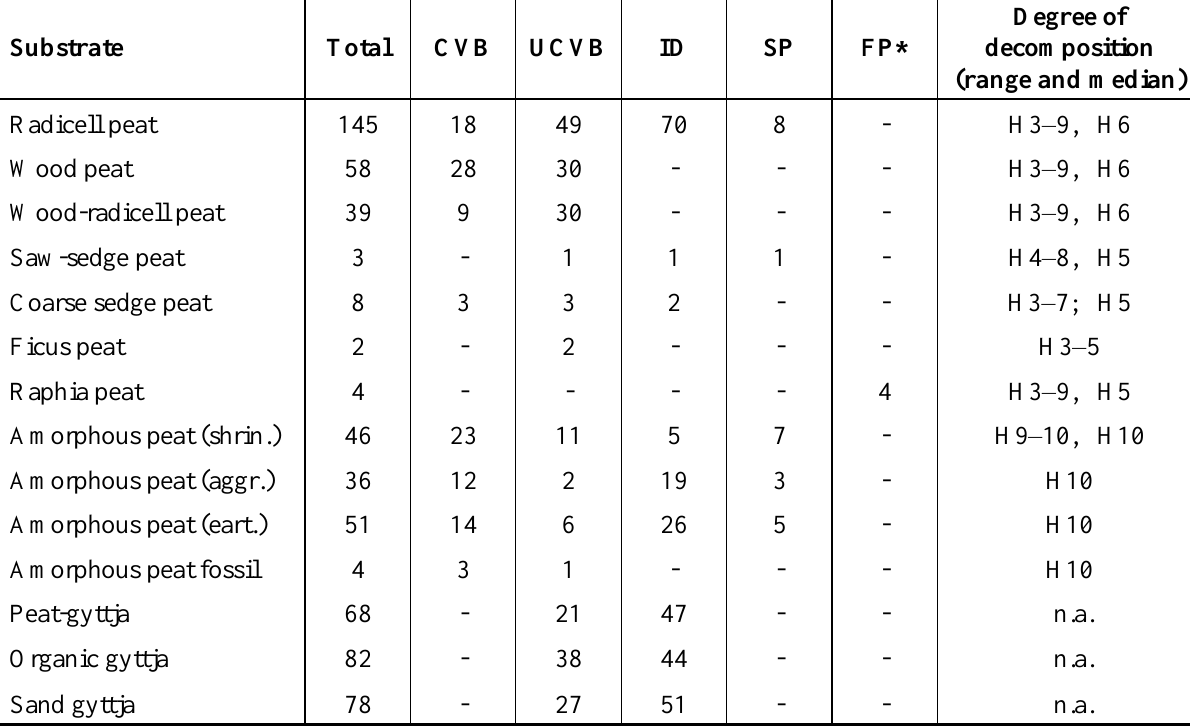
Table 4. Frequencies of horizons belonging to individual substrate types within each HGMT: CVB = channelled valley bottom, UCVB = unchannelled valley bottom, ID = interdune depression, SP = seep, FP = floodplain; n.a. = not